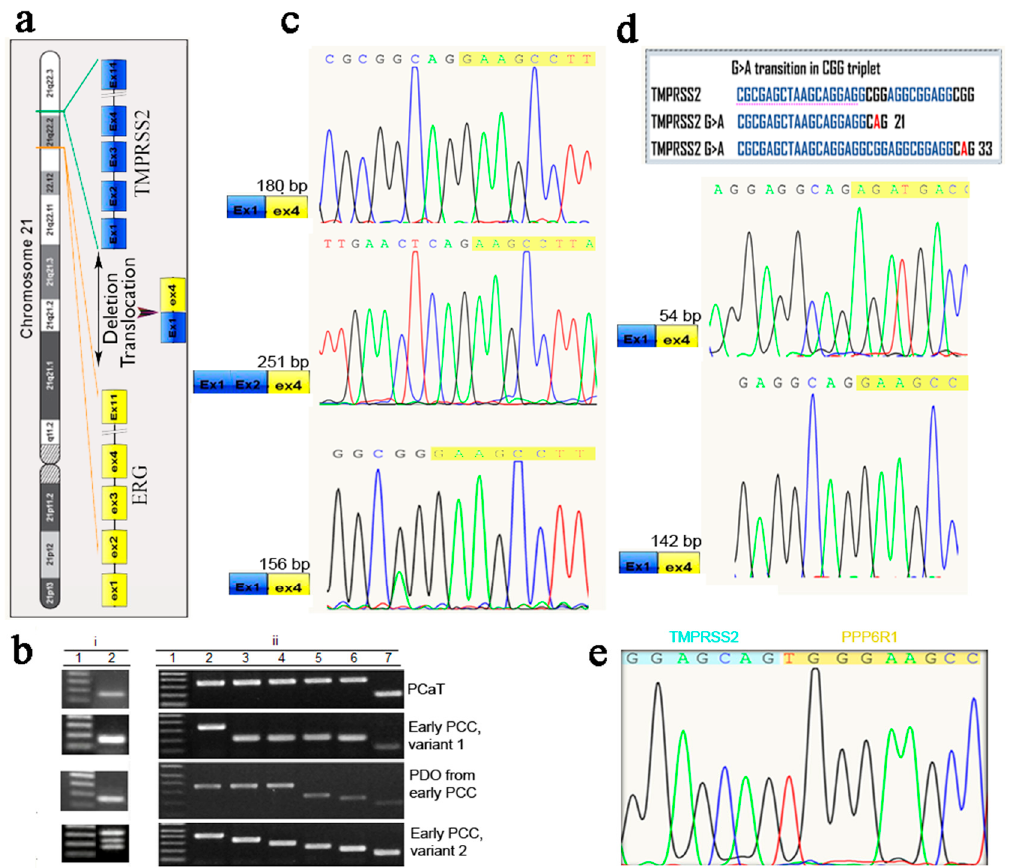
Figure 5. Verification of expression of prostate cancer marker TMPRSS2-ERG in PCaT, early PCCs and derived PDOs by RT-PCR followed by cloning and sequencing of the amplification products. ( a ) Diagram of TMPRSS2-ERG gene fusion on chromosome 21. ( b ) Detection of TMPRSS2-ERG fusion transcripts by ( i ) RT-PCR and ( ii ) T/A cloning of the amplified RT-PCR products. ( i ) Amplification